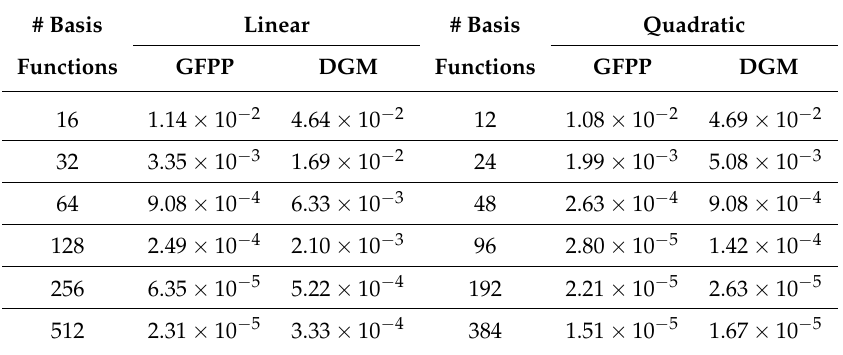
Table 4. The error estimation of numerical solutions to the European put